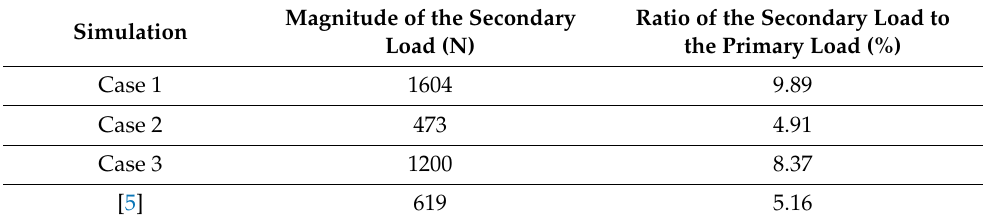
Table 14. Comparison of the magnitude of the secondary load for different